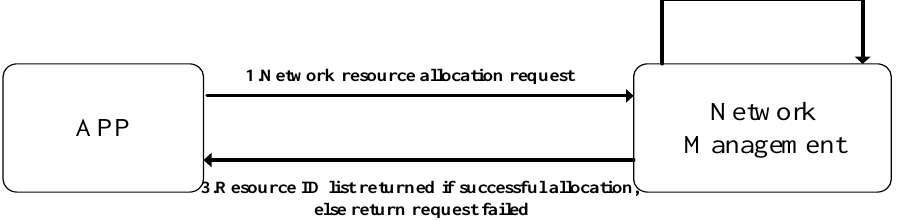
Figure 11. The network manager allocates network resources to applications.